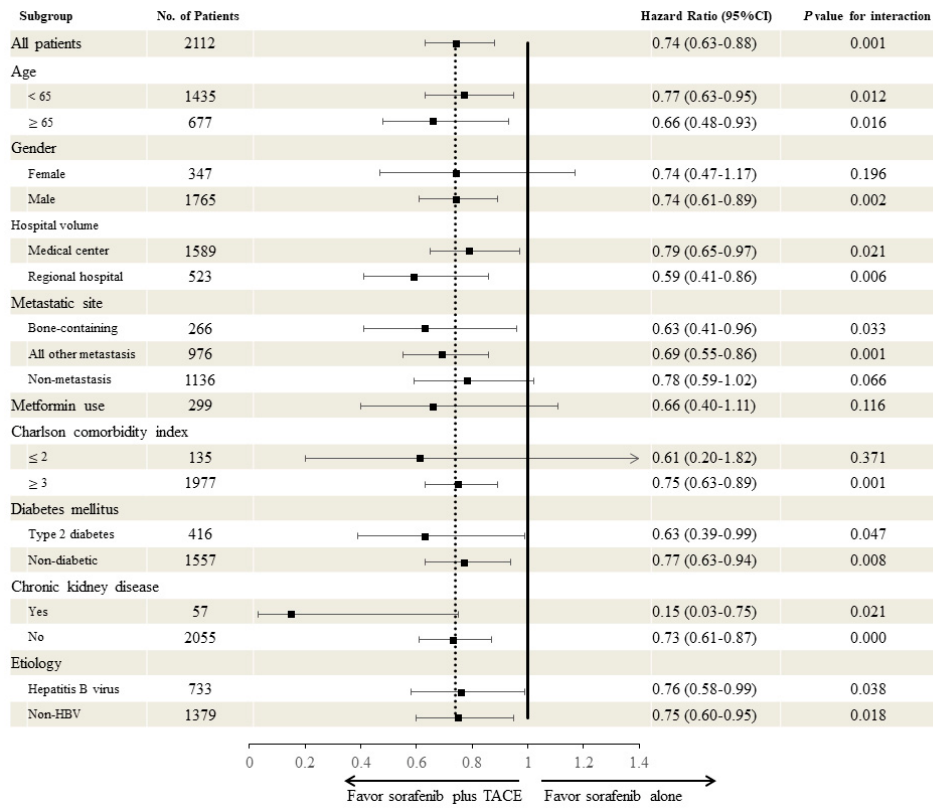
Figure 3. Subgroup analysis based on the characteristics of the cohort of patients with unresectable hepatocellular carcinoma receiving sorafenib with or without add-on TACE. Time-dependent Cox